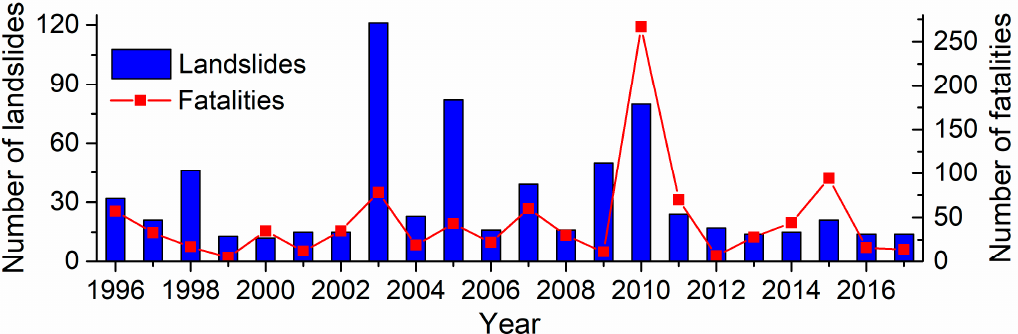
Figure 3. Graph showing the number of landslides and number of landslide fatalities each year for the period of 1996–2017. ISPRS Int. J. Geo-Inf. 2019 , 8 , x FOR PEER REVIEW